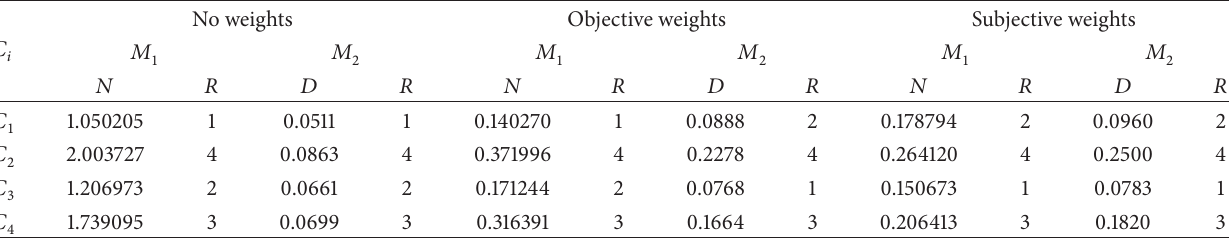
Table 7: The results comparison between the proposed approach and the reported